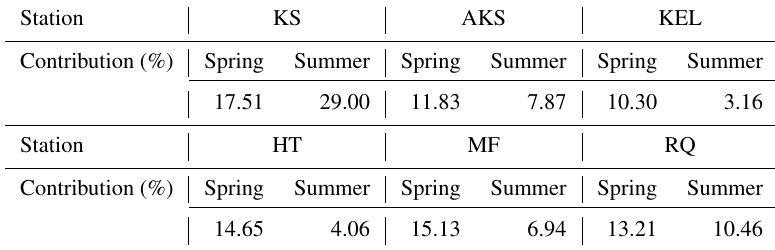
Table 2. Contribution of suspended dust to the anomalously warm atmospheric layer at 500–300hPa altitude over the TB. Station KS AKS KEL Contribution (%) Spring Summer Spring Summer Spring